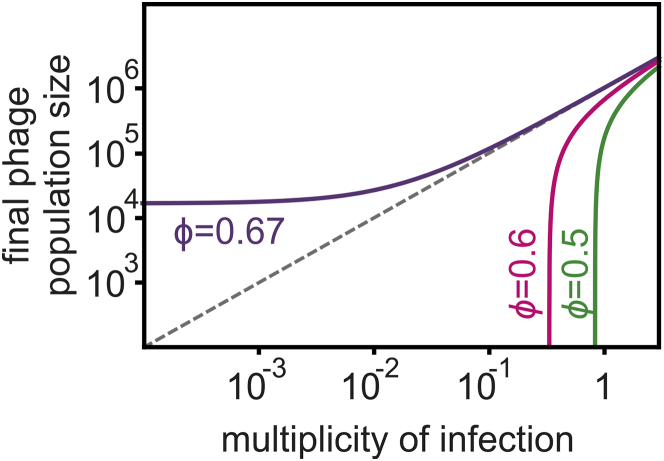
Partial Immunity Alone Cannot Explain the Observed Epidemiological Tipping Points, Related to Figure 4Model predictions of the effect of initial Acr-phage inoculum density on the phage density at 24hpi for different values of Acr strength when no immunosuppressive state S is assumed in the model (ϕ = 0.67, 0.6 and 0.5; purple, magenta, green respectively); other parameter values: B = 5, α = 0.001, γ = 20, ρ = 0.7. Grey line corresponds to the initial amount of phage and values below this line indicate a lack of phage amplification.